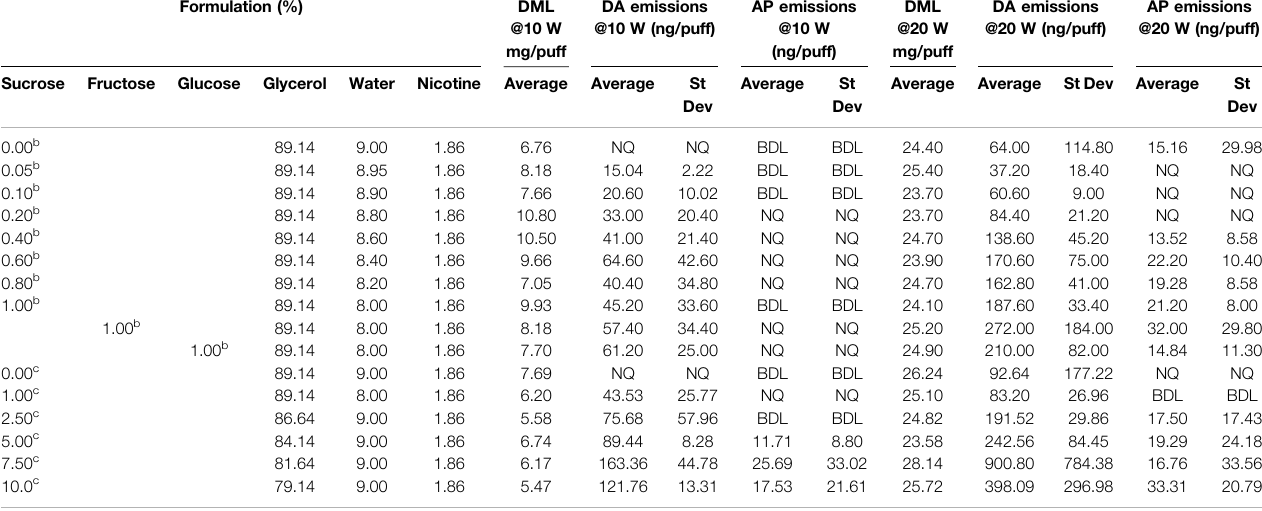
TABLE 5 | Device mass losses and aerosol yields of AC a , AP and DA per puff at power settings of 10 and 20 W, from 0 to 10% sucrose solutions. Formulation (%)